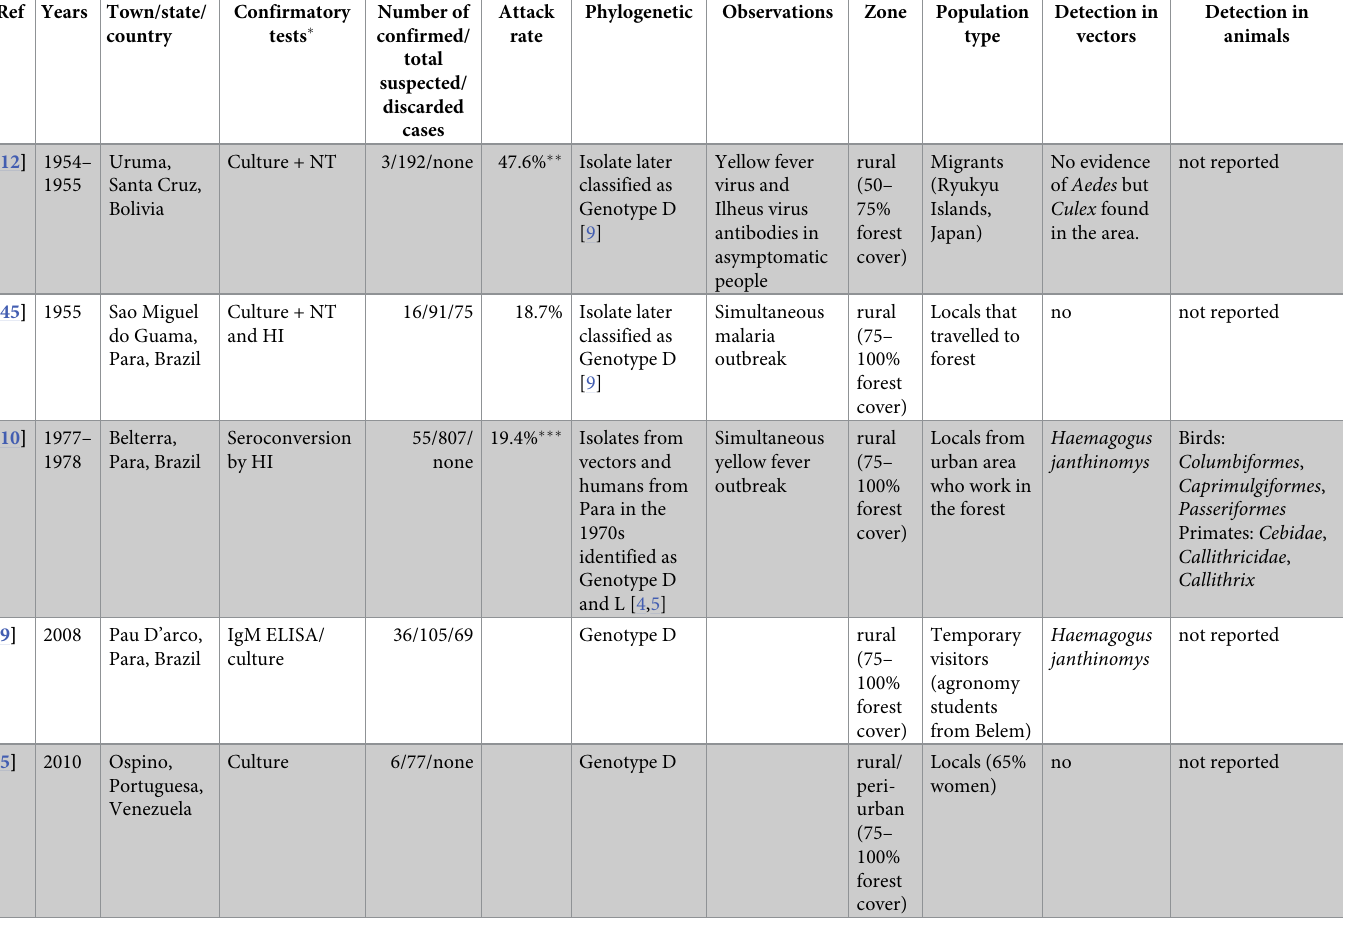
Table 1. Characteristics of MAYV outbreaks (n =